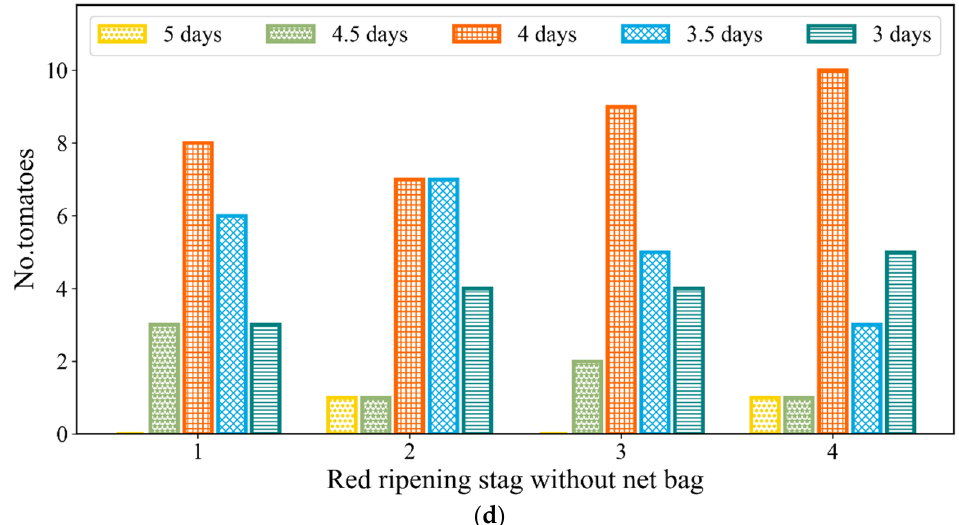
Figure 16. The statistical results of tomatoes shelf-life: ( a ) Turning stage with net bag; ( b ) Red ripening stag with net bag; ( c ) Turning stage without net bag; ( d ) Red ripening stag without net bag.